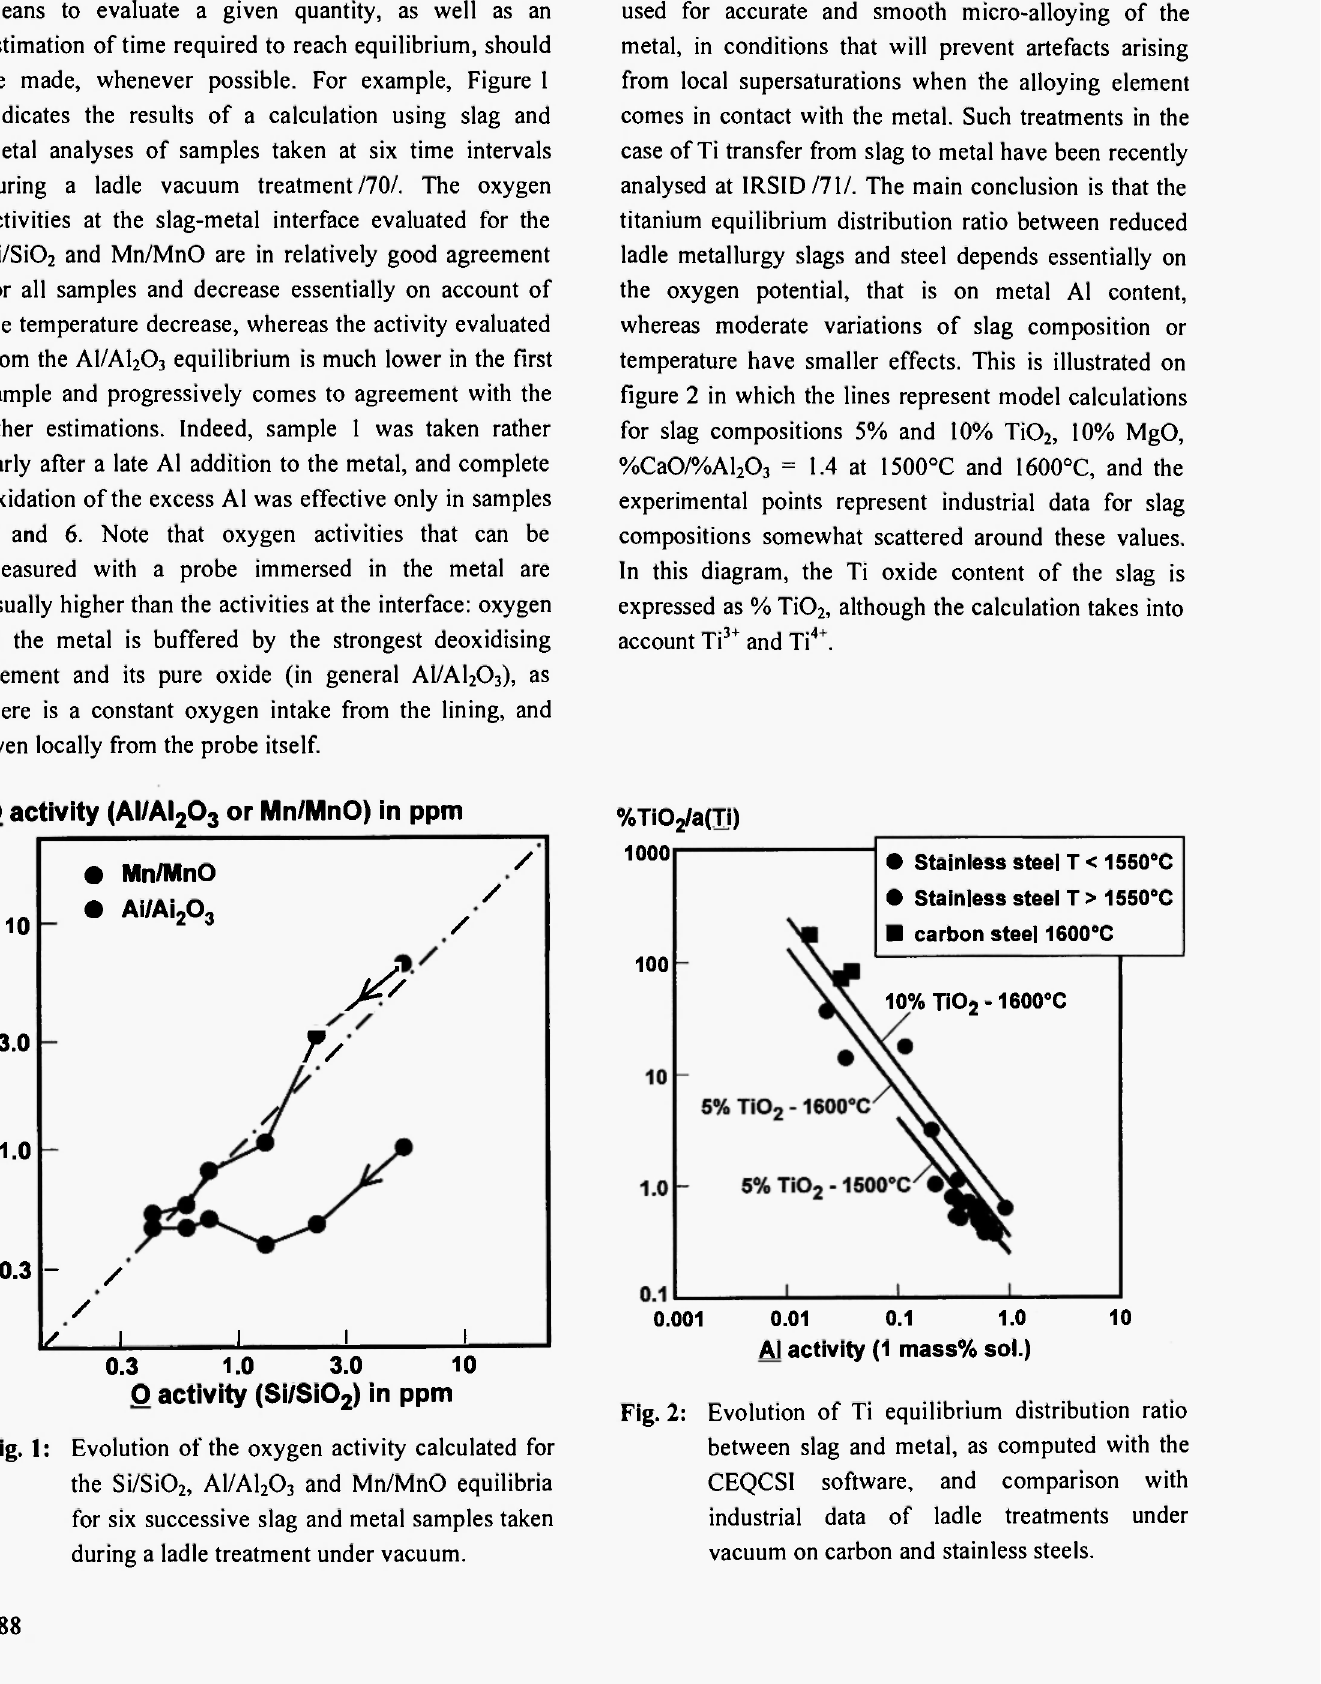
Fig. 2: Evolution of Ti equilibrium distribution ratio between slag and metal, as computed with the CEQCSI software, and comparison with industrial data of ladle treatments under vacuum on carbon and stainless